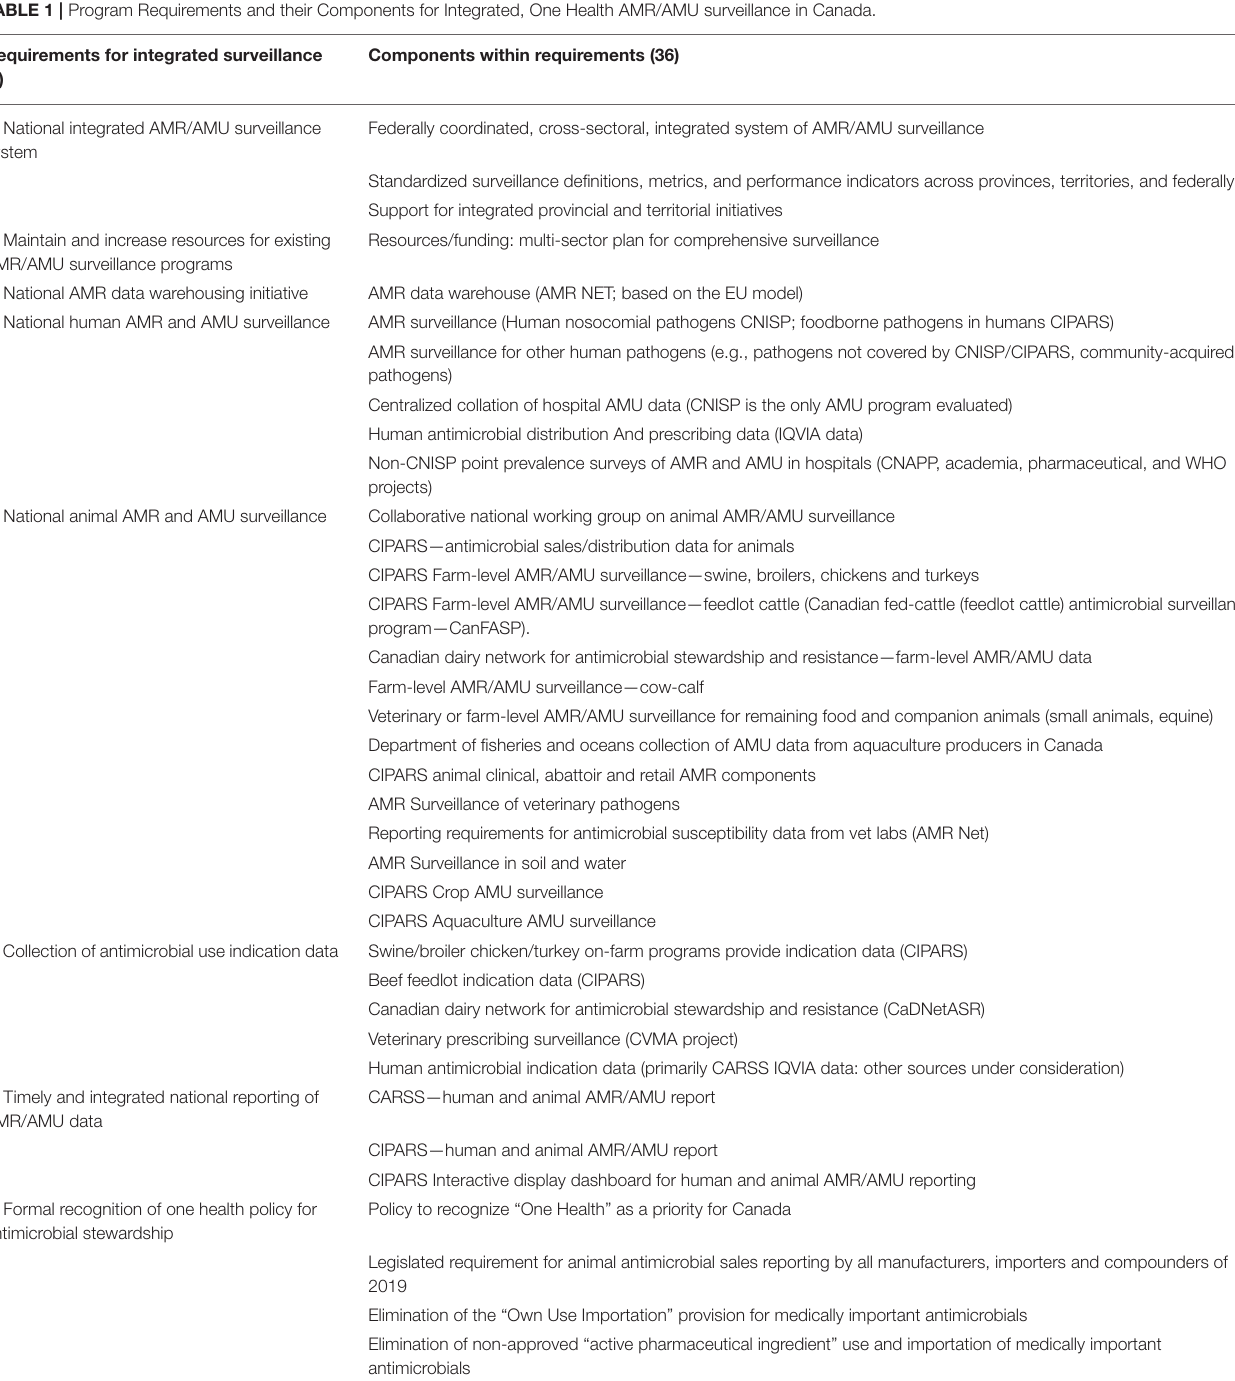
TABLE 1 | Program Requirements and their Components for Integrated, One Health AMR/AMU surveillance in